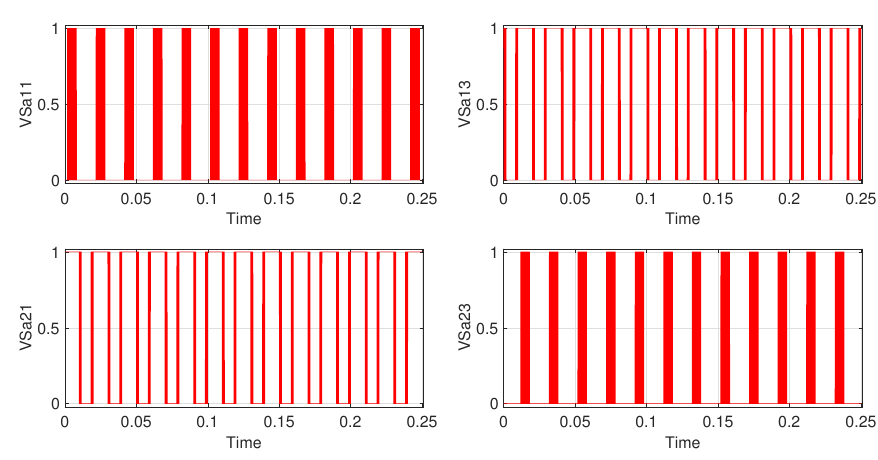
Figure 8. The single-phase PWM signals of CHB inverter. The single-phase output voltage and current of the five-level CHB inverter is shown in Figure 9. The analog implementation is used for PWM control in order to acquire gate signals and single-phase results. Since the VVVF method needs to be performed with an algorithmic approach by its nature, a digital implementation of the PWM technique is utilized in order to obtain the single-phase output voltage and current under VVVF control. Its single-phase outcomes are shown in Figure 10.